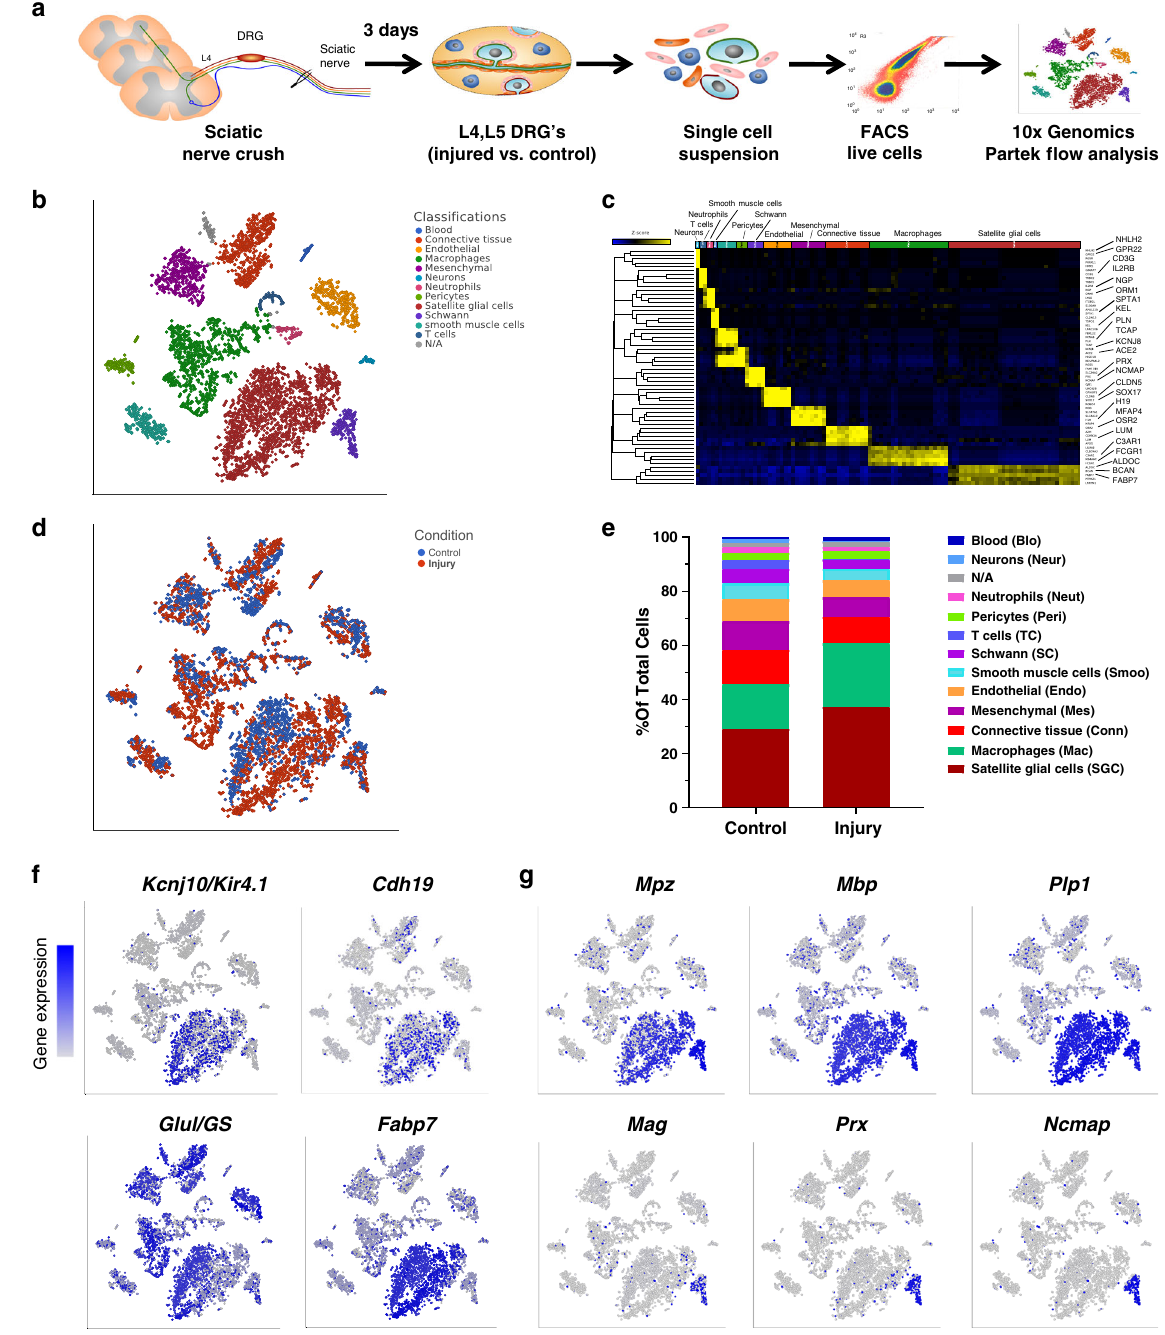
Fig. 1 Characterization of cell populations in the DRG. a Schematic of the experimental design for scRNAseq. b t-SNE plot of 6,541 cells from L4, L5 mouse dissociated DRG, with 13 distinct cell clusters (Unbiased, Graph based clustering). Classi fi cations were assigned based on known marker genes. c Heatmap of the top fi ve differentially expressed genes per cluster relative to all other clusters. d t-SNE plot of cells from naïve (blue) and injury (red) conditions. e Fraction of each cell type within control (2915 cells) and injury (3626 cells) conditions. n = 2 biologically independent experiments. Source data are provided as a Source Data fi le. f t-SNE overlaid for expression of marker genes for SGC. g t-SNE overlaid for expression of marker genes shared between Schwann cells and SGC (top panel) and marker genes for Schwann cell only (bottom